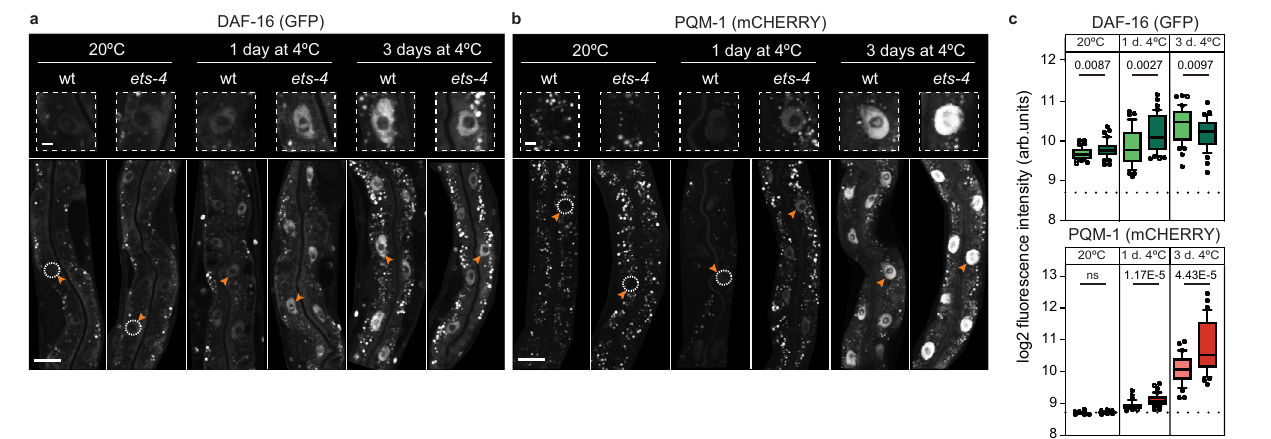
Fig. 3 | DAF-16 and PQM-1 are enriched in the gut nuclei of cold-exposed nematodes. a Representative confocal images showing nuclear accumulation of DAF-16. Wild type or ets-4(rrr16) mutants, both containing endogenously GFP- tagged DAF-16 (allele daf-16(syb707) ), were sampled at the indicated times and temperatures, as in Fig. 1a, and the GFP fl uorescence was imaged (quanti fi ed in c , left). Arrowheads point to representative gut nuclei (demarcated with dashed circles when displaying little or no fl uorescence), which are enlarged in the insets above. Size bars, here and in b : 25 μ m (small magni fi cation) and 5 μ m (large mag- ni fi cation). b Representative confocal images showing nuclear accumulation of PQM-1. Wild type or ets-4(rrr16) mutants, both containing endogenously mCherry-